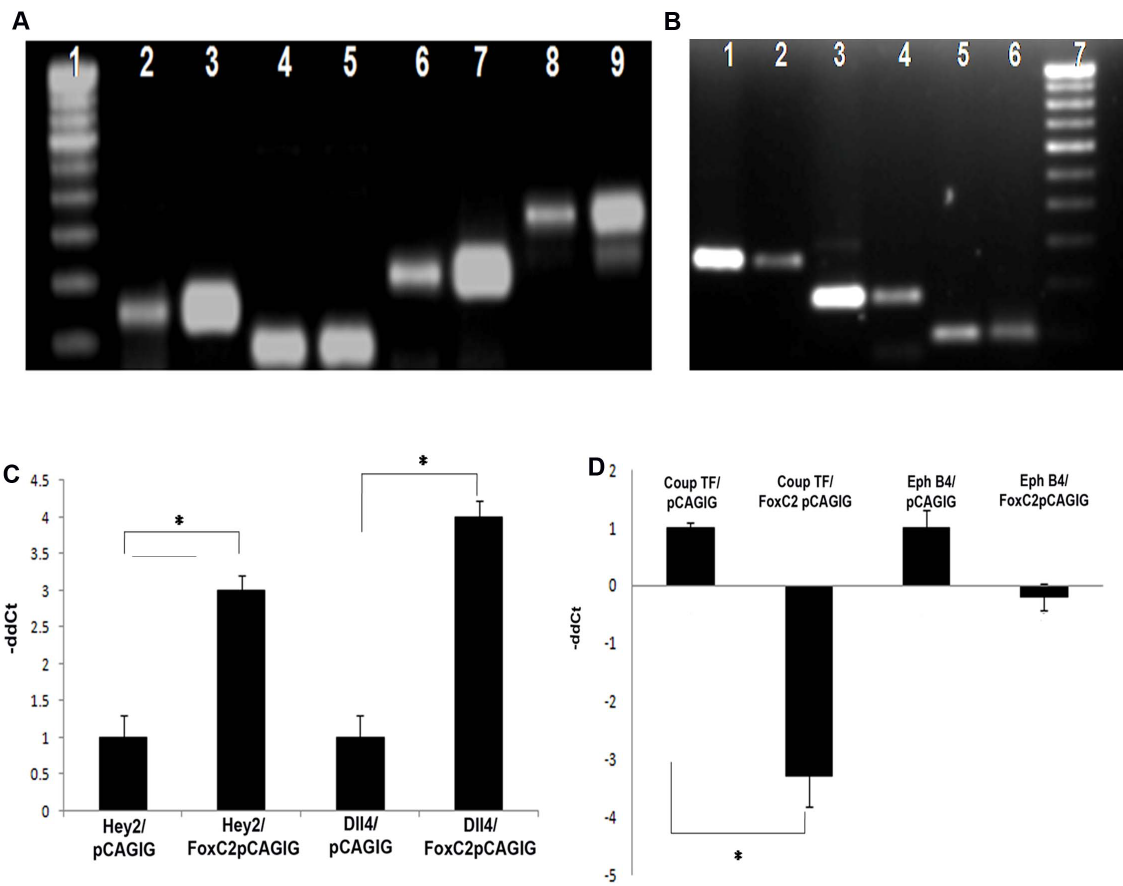
Figure 5. FoxC2 based regulation of Hey2 , Dll4 , COUPTFII and EphrinB4 expression in EA.hy926 cells. (A) Gel image showing increased expression of Dll4 and Hey2 mRNA in EA.hy926 cells transfected with FoxC2 –pCAGIG. Lane 1: 100 bp molecular ladder, Lane 2, 4, 6, 8: FoxC2, GAPDH, Dll4 and Hey2 mRNA levels in cells transfected with pGAGIG control vector. Lane 3, 5, 7, 9: FoxC2, GAPDH, Dll4 and Hey2 mRNA levels in FoxC2 - pGAGIG construct transfected cells. (B) Gel image showing increased expression of COUP TFII and Ephrin B4 mRNA in EA.hy926 cells transfected with FoxC2 – pCAGIG. Lane 1, 3, 5: Ephrin B4, COUP TFII and GAPDH mRNA levels in cells transfected with empty pGAGIG control vector. Lane 2, 4, 6: Ephrin B4, COUP TFII and GAPDH mRNA levels in FoxC2 - pGAGIG construct transfected cells, Lane 7: 100 bp molecular ladder (C) Relative mRNA levels of Hey2 and Dll4 measured by qRT-PCR. (D) Relative mRNA levels of COUP TFII and Ephrin B4 measured by qRT-PCR. Values are mean 6 s.d. of triplicate experiments from 3 samples per each group. Statistical significance was determined by Student’s t-test (*p , 0.05 versus